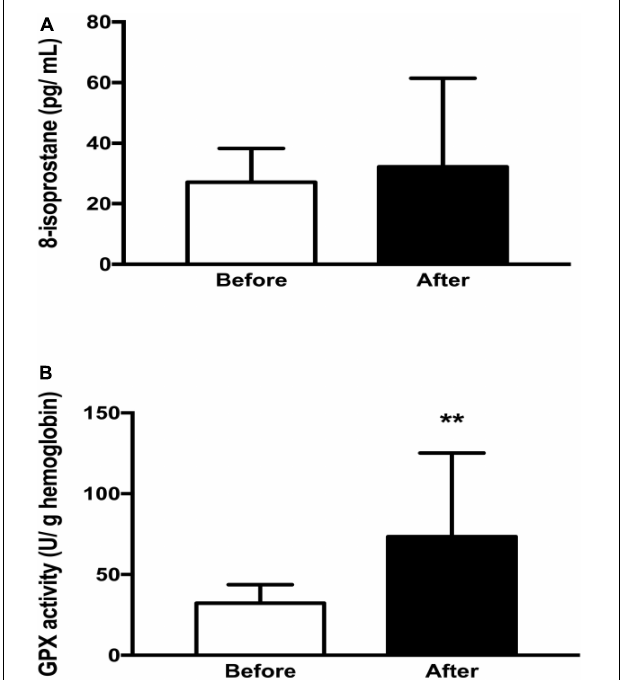
FIGURE 2 | NGAL in blood and urine of the athletes before and after the competition ( n = 7). (A) Serum NGAL values before and after ultramarathon. (B) Urinary NGAL values before and after ultramarathon. sNGAL, serum neutrophil gelatinase-associated lipocalin; uNGAL, urinary neutrophil gelatinase-associated lipocalin; ng/ml, nanograms per milliliter. The ** means that the result was statistically significant ( p < 0.01).